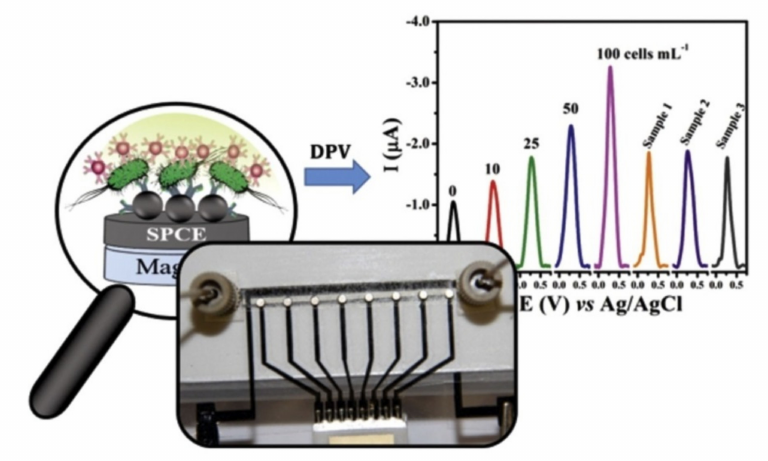
Figure 10. The microfluidic device connectors and the eight magnets externally attached with double-sided tape over each working electrode, together with a schematic representation of detection. Adapted with permission from [134] Copyright 2018,